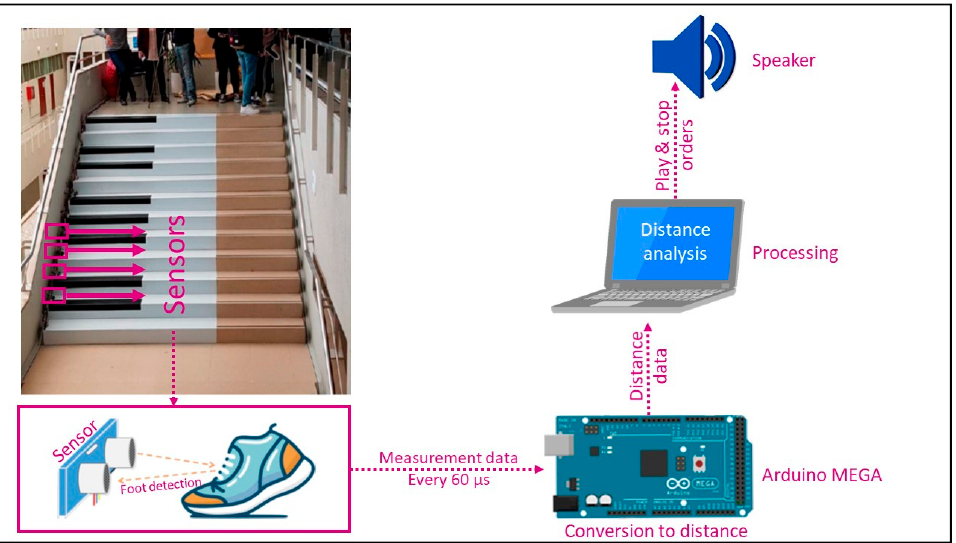
Figure 1. Operating diagram of “The Music Stairs” (source: the